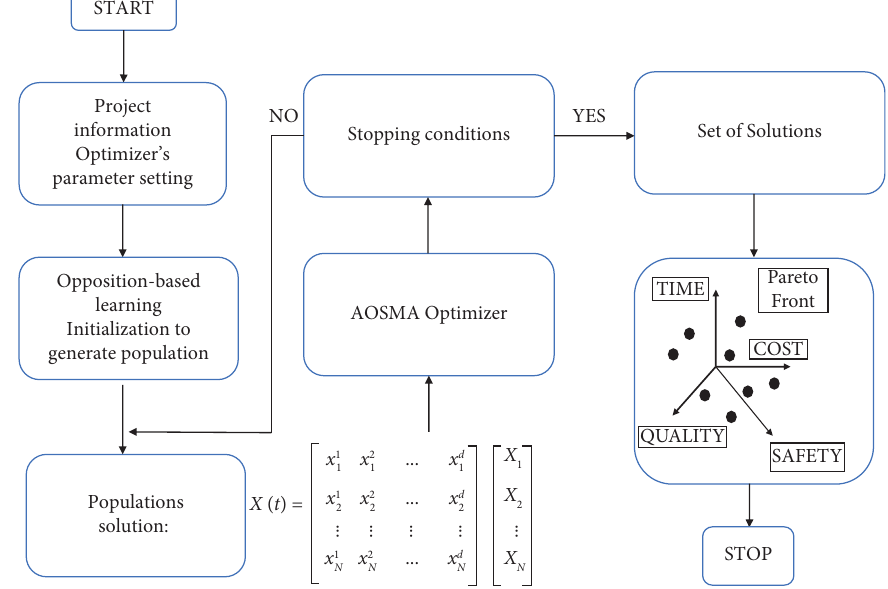
Figure 1: Flowchart of